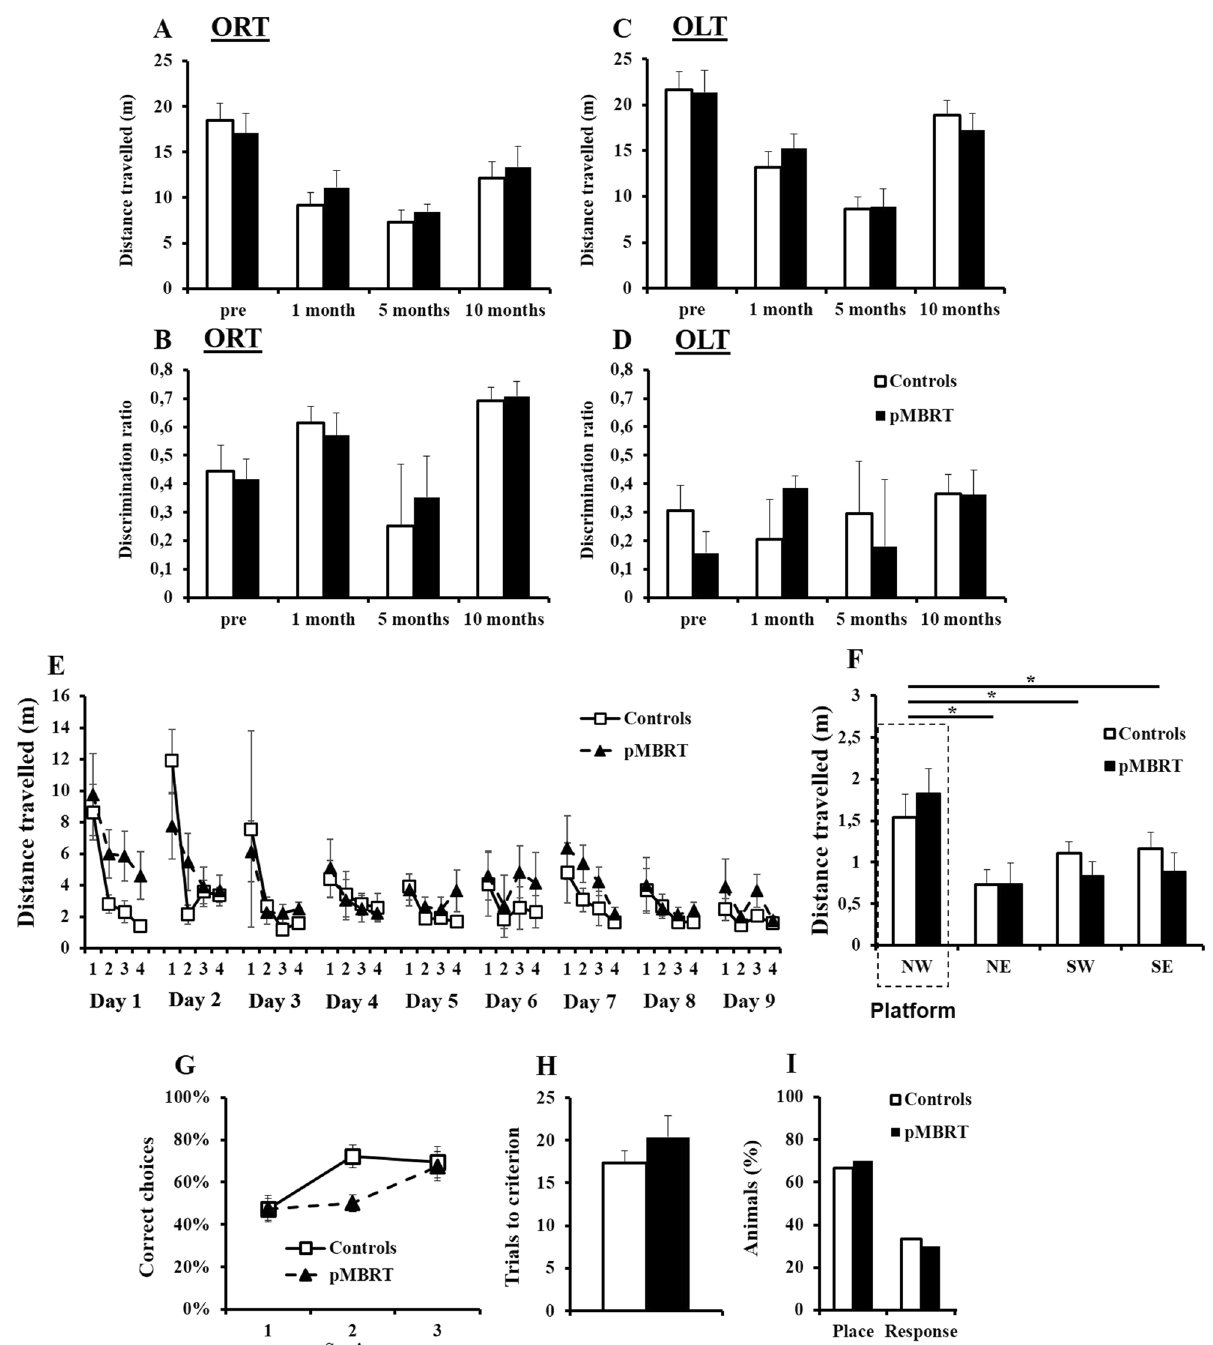
Figure 3. Memory assessment. Similar mean distance travelled by both groups in the ORT ( A ) and OLT ( C ) at 48 h before irradiation and 1, 5, and 10 months post-irradiation (PI). Similar mean discrimination ratio for both groups in the ORT ( B (time spent exploring the novel object – time spent exploring the familiar object)/time spent exploring both objects) and in the OLT ( D (time spent exploring the novel location of the object – time spent exploring the familiar location)/time spent exploring both objects) at 48 h before irradiation and 1, 5, and 10 months PI. Similar mean distance travelled to find the platform across trials by both groups in the MWM test at 7 months PI ( E ). Similar mean distance travelled in each quadrant of the MWM by both groups during the probe test ( F ). Similar mean percentage of correct choices to find the east arm ( G ) and mean number of trials needed to reach the learning criterion ( H ) during the training sessions of the cross-maze test for both groups. The majority of animals showed a place strategy (east arm) rather than a response strategy (west arm) during the probe test, and there was no significant difference between the groups ( I ). The data are presented as the mean ± SEM; *p <